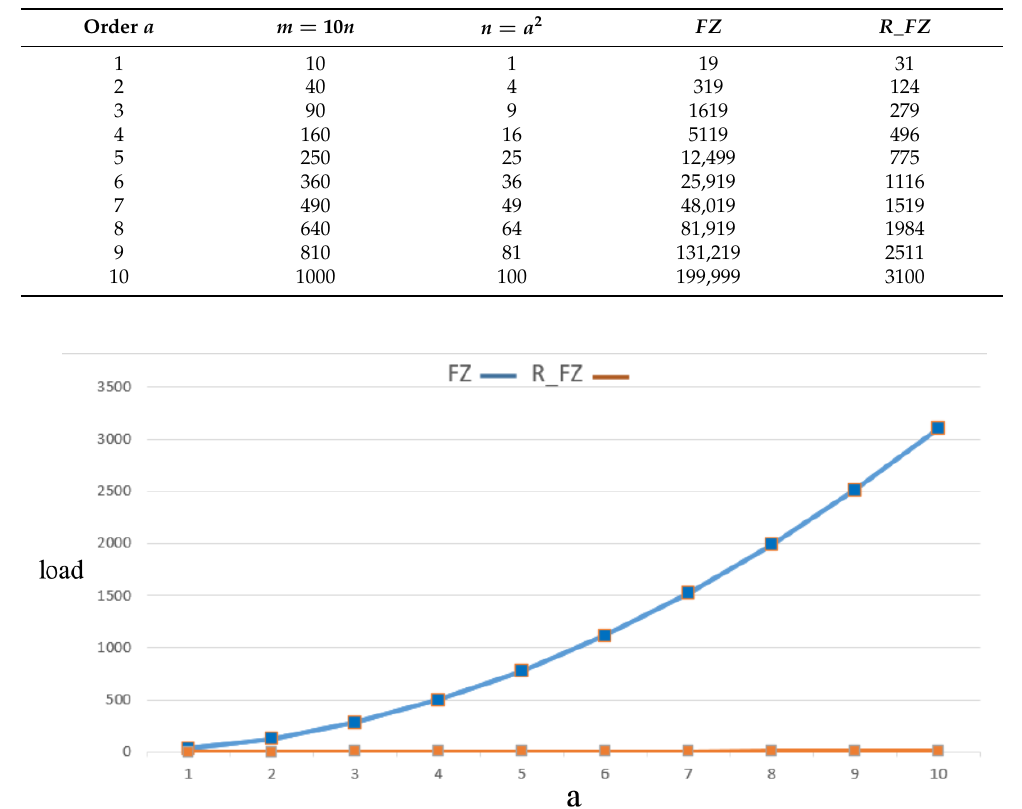
Table 5. Contrast with traditional random loads.